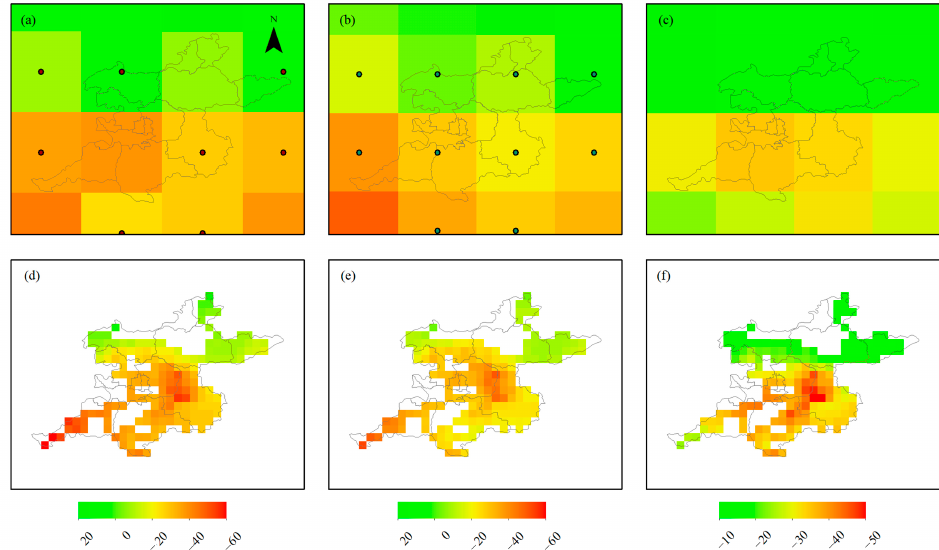
Figure 11. The simulated GWSA based on the NSFWC scheme. ( a ) 0.5° JPL-GWSA; ( b ) 0.5° CSR- GWSA; ( c ) 0.5° CLSM-GWSA; ( d ) 0.05° simulated JPL-GWSA; ( e ) 0.05° simulated CSR-GWSA; ( f ) 0.05° simulated CLSM-GWSA. The grey dots represent areas with non-significant trends ( p ≥ 0.05).